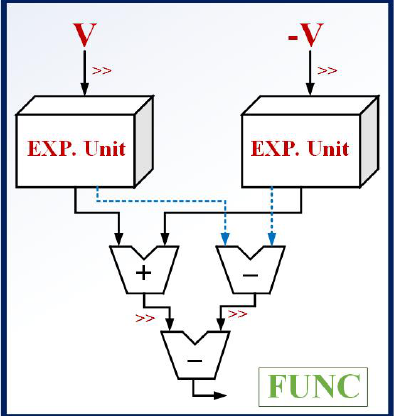
Figure 7. Realizationof the proposed FUNC ( V )